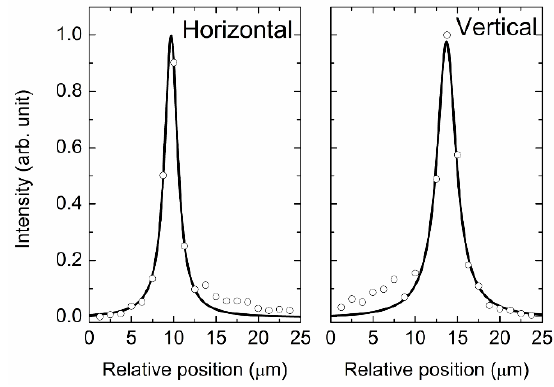
Figure 1. ( Top ) Top-view photograph of the VUVCD spectrophotometer sample chamber after Schwarzschild objective (SO) installation. ( Bottom ) A schematic view of beam focusing using the SO.